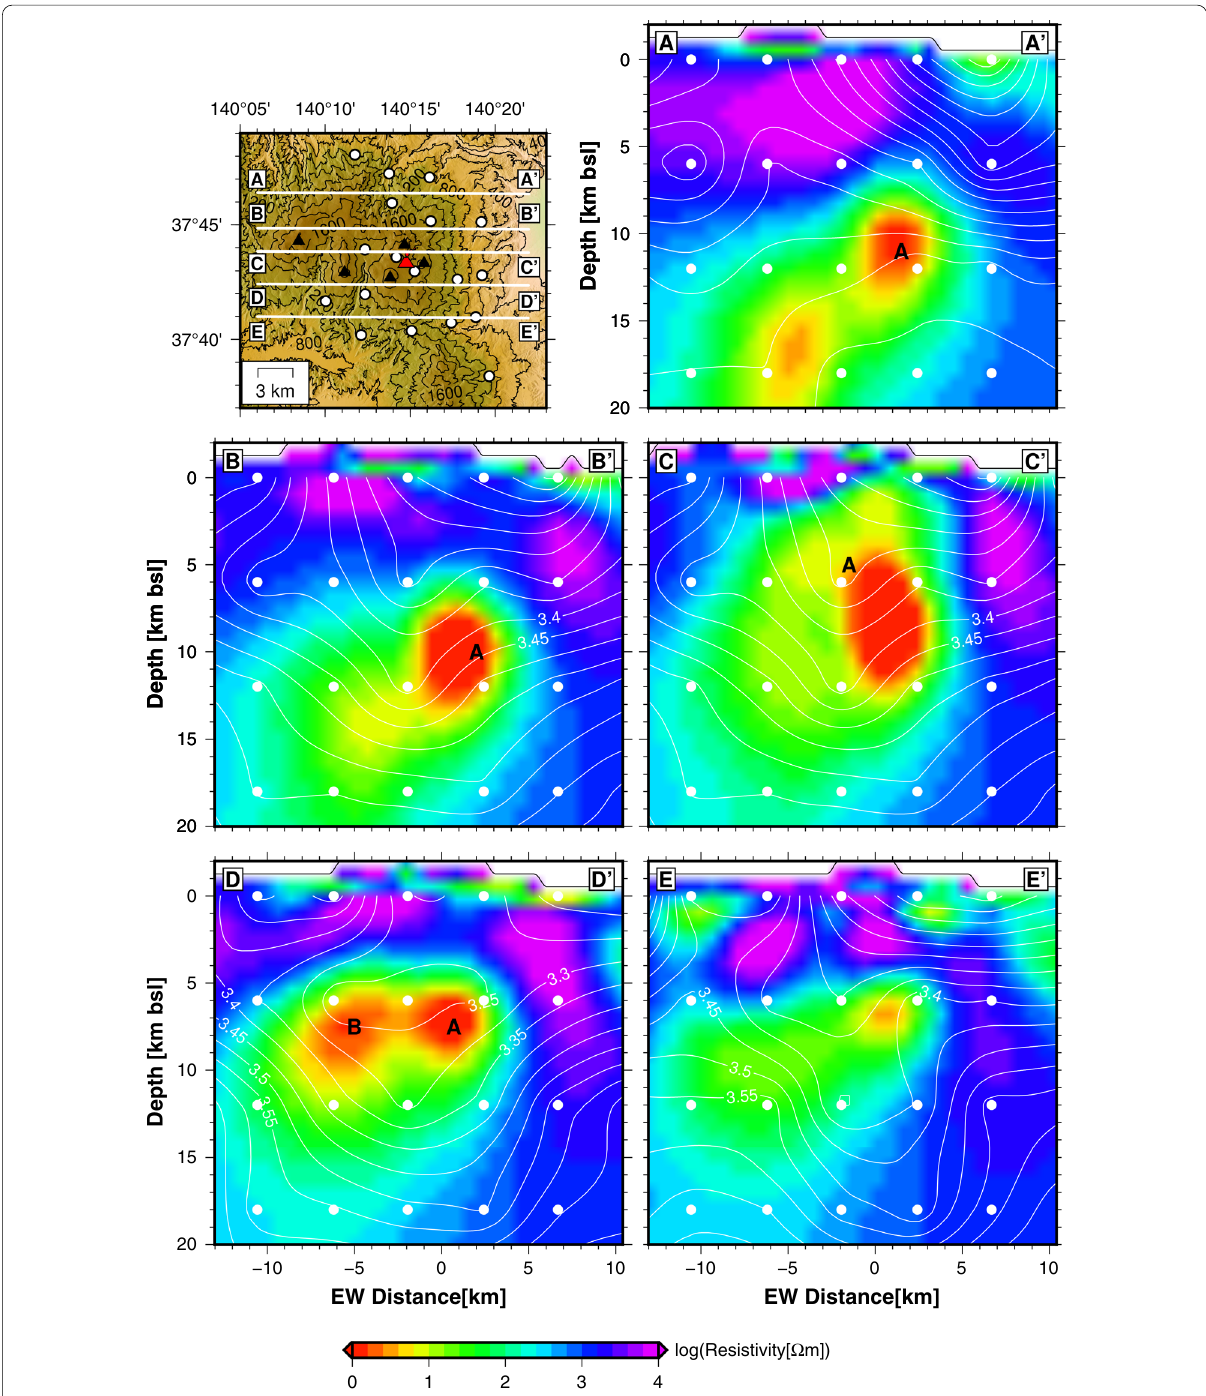
Fig. 16 Vertical profiles of the V s model by Okada et al. (2015) superimposed on the resistivity model (Fig. 6) in the E–W direction. The white lines and circles are V s contours and sampling point of the V s model. Other features are the same as those in Fig.